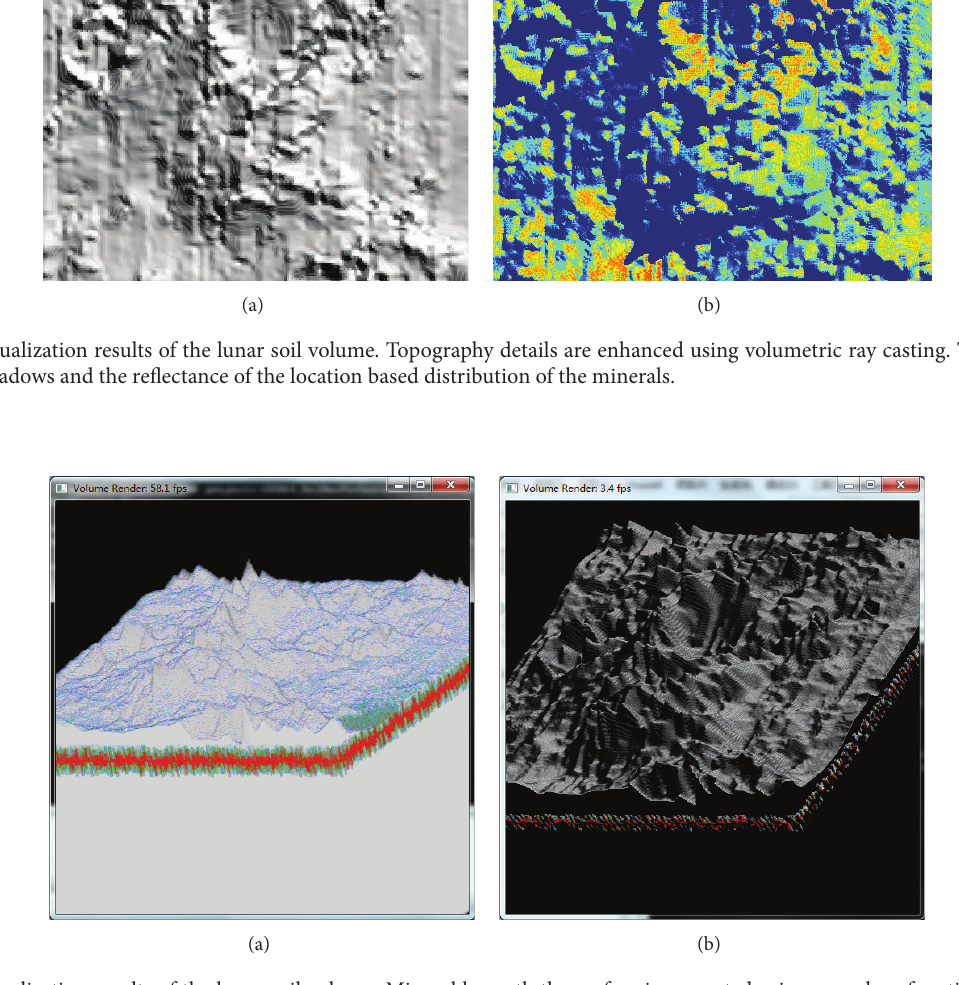
Figure 23: Visualization results of the lunar soil volume. Mineral beneath the surface is generated using a random function. (a) the result without shading effect; (b) the result with shading